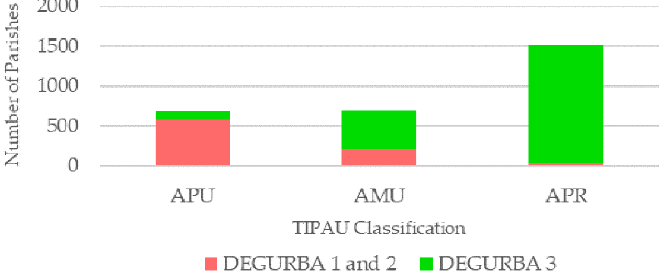
Figure 7. Number of parishes with different classification considering TIPAU 2014 and DEGURBA 2014.